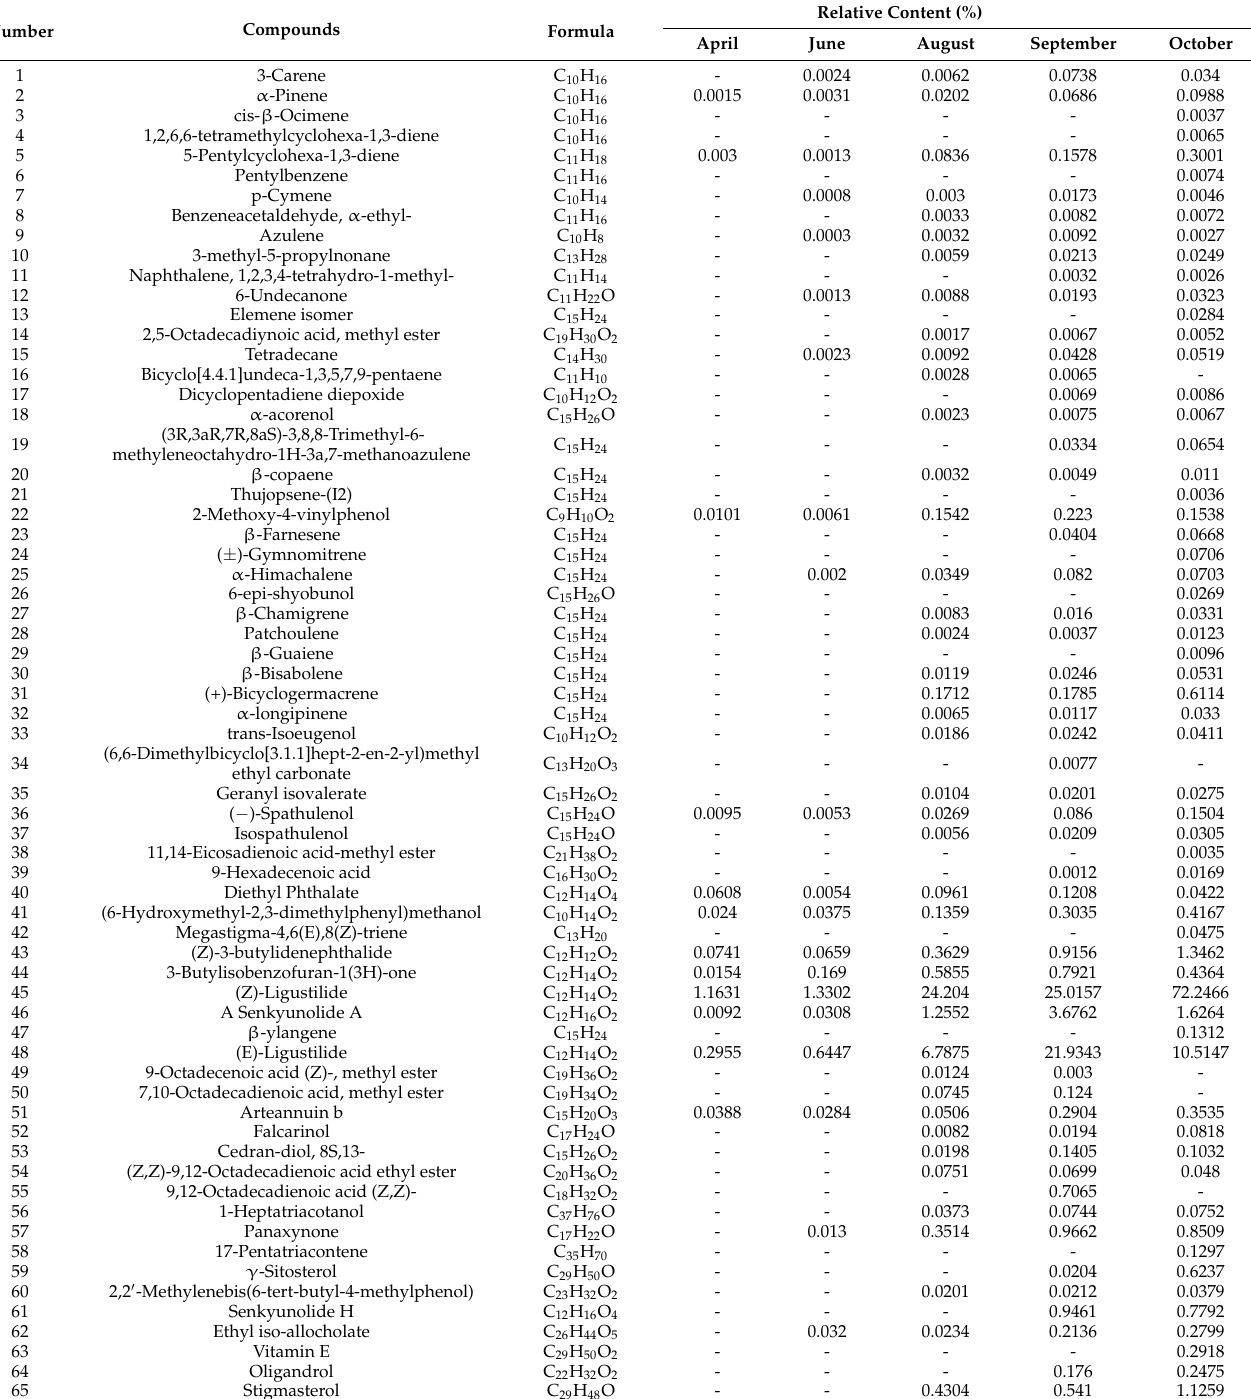
Table 1. Analysis of chemical components in the head of A. sinensis in different